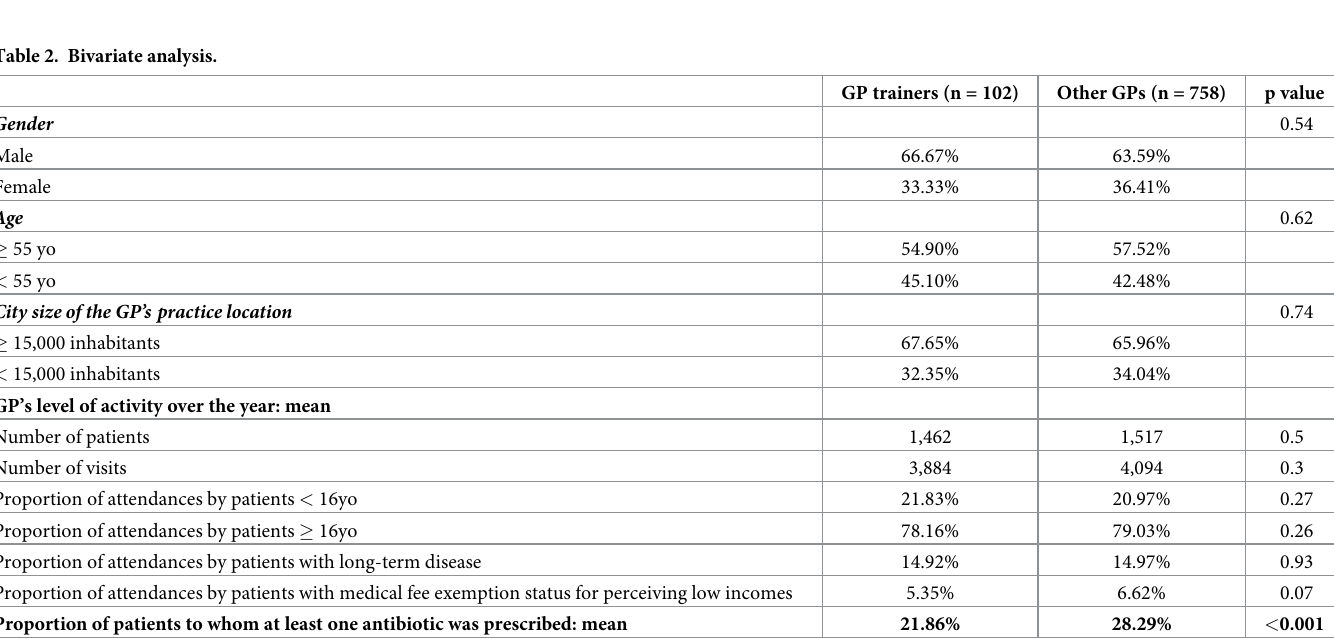
Table 2. Bivariate